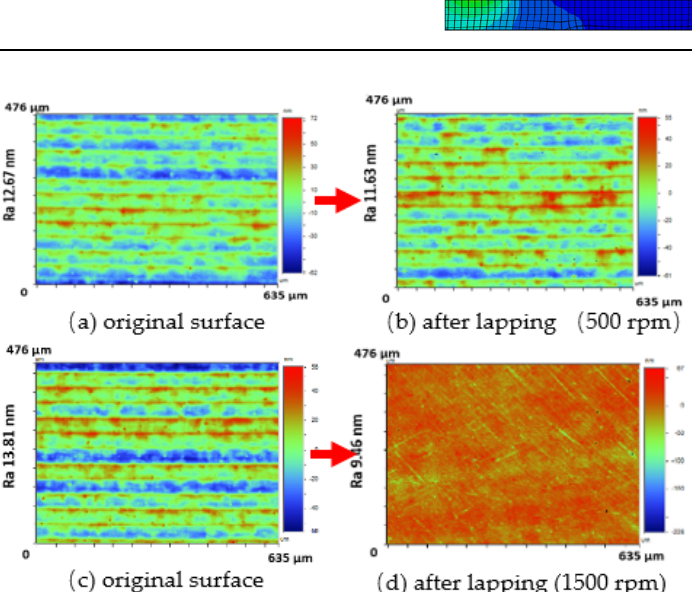
Figure 6. Two surfaces ( a , c ) with tool marks lapped under different rotational speed. The surface ( b ) had almost no change at a rotational speed of 500 rpm. The surface ( d ) started to show pits and scratches at a rotational speed of 1500 rpm [1].